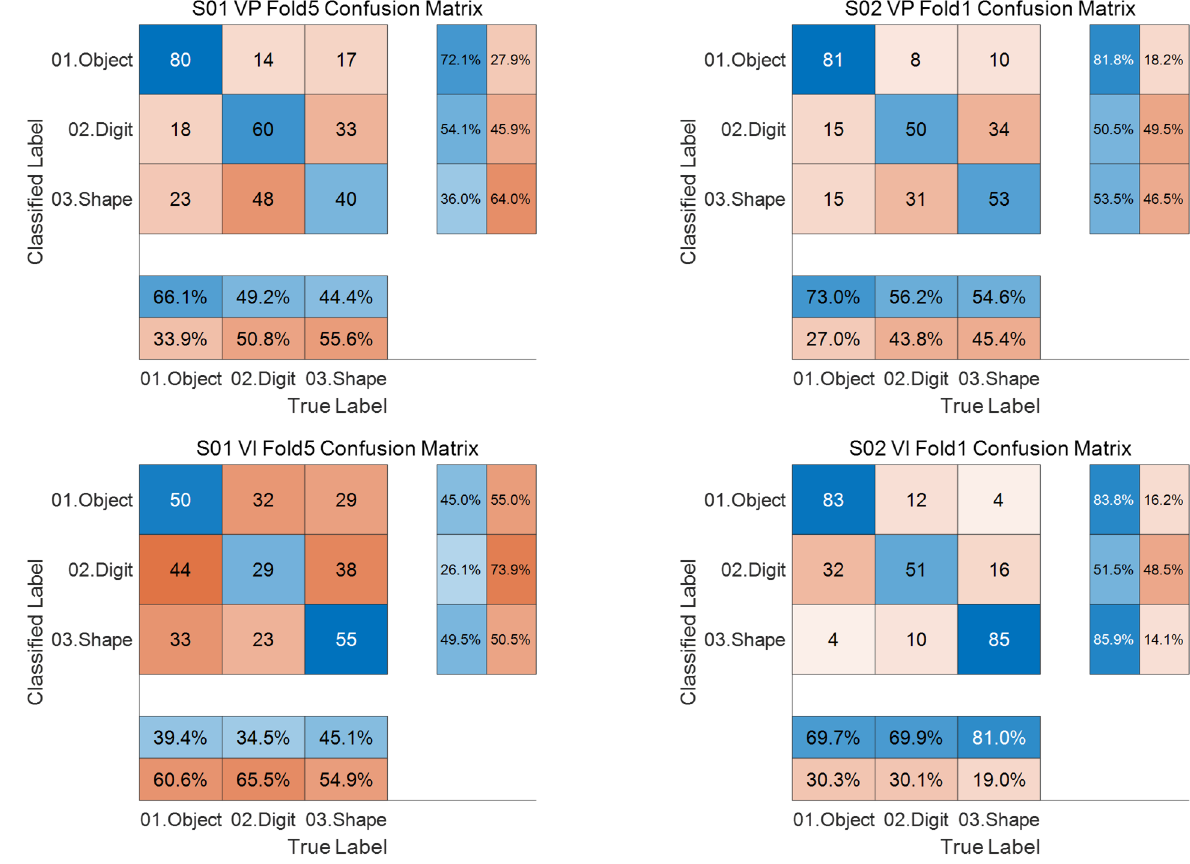
Figure 8. Exemplary confusion matrix of S01 and S02’s 3-category classification using MultiRocket classifier in VP and VI.